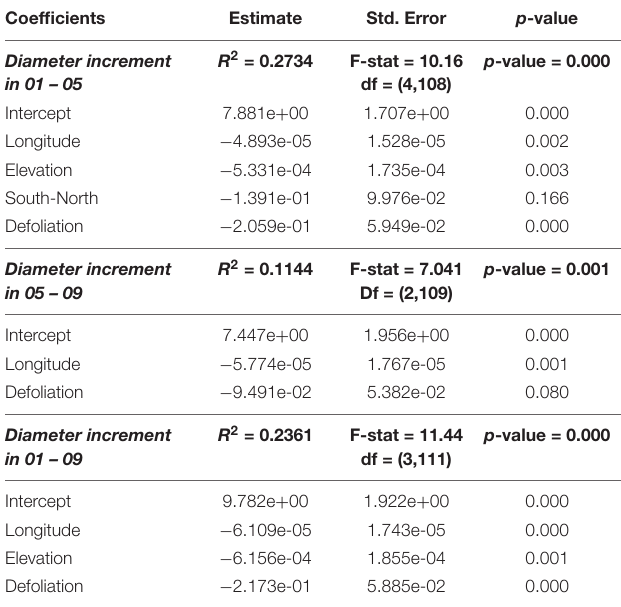
TABLE 2 | Models describing the relation between square roots of diameter increments (in cm, before transformation) and square roots of defoliation values (in %, before transformation) as well as other